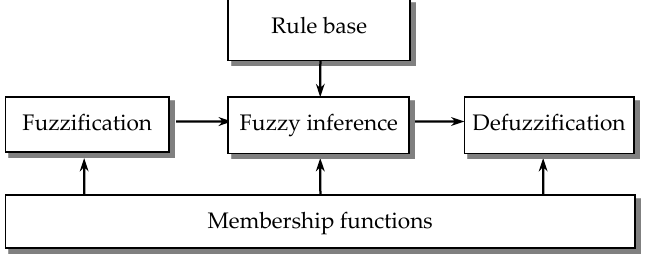
Figure 1. A fuzzy system.